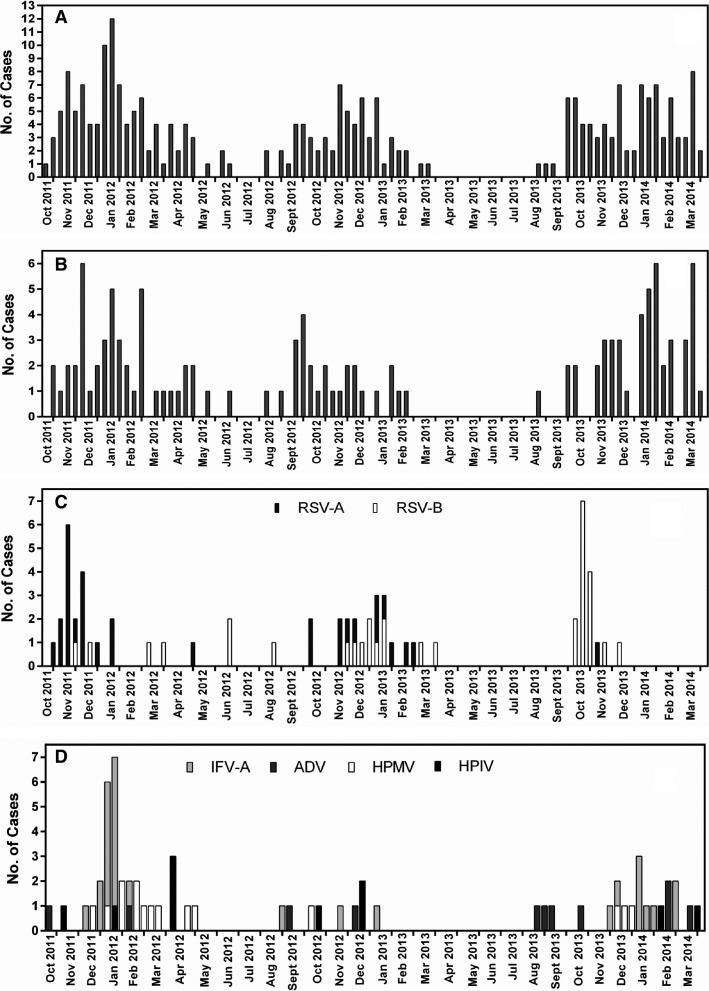
Seasonal distribution of the most prevalent respiratory viruses: (A) total viral infections, (B) HRV, (C) RSV, (D) IFV-A, ADV, HMPV, and HPIV in children with ARI from the National Institute of Respiratory Diseases in Mexico City between October 2011 and March 2014. Y-axis and bars describe number of cases.